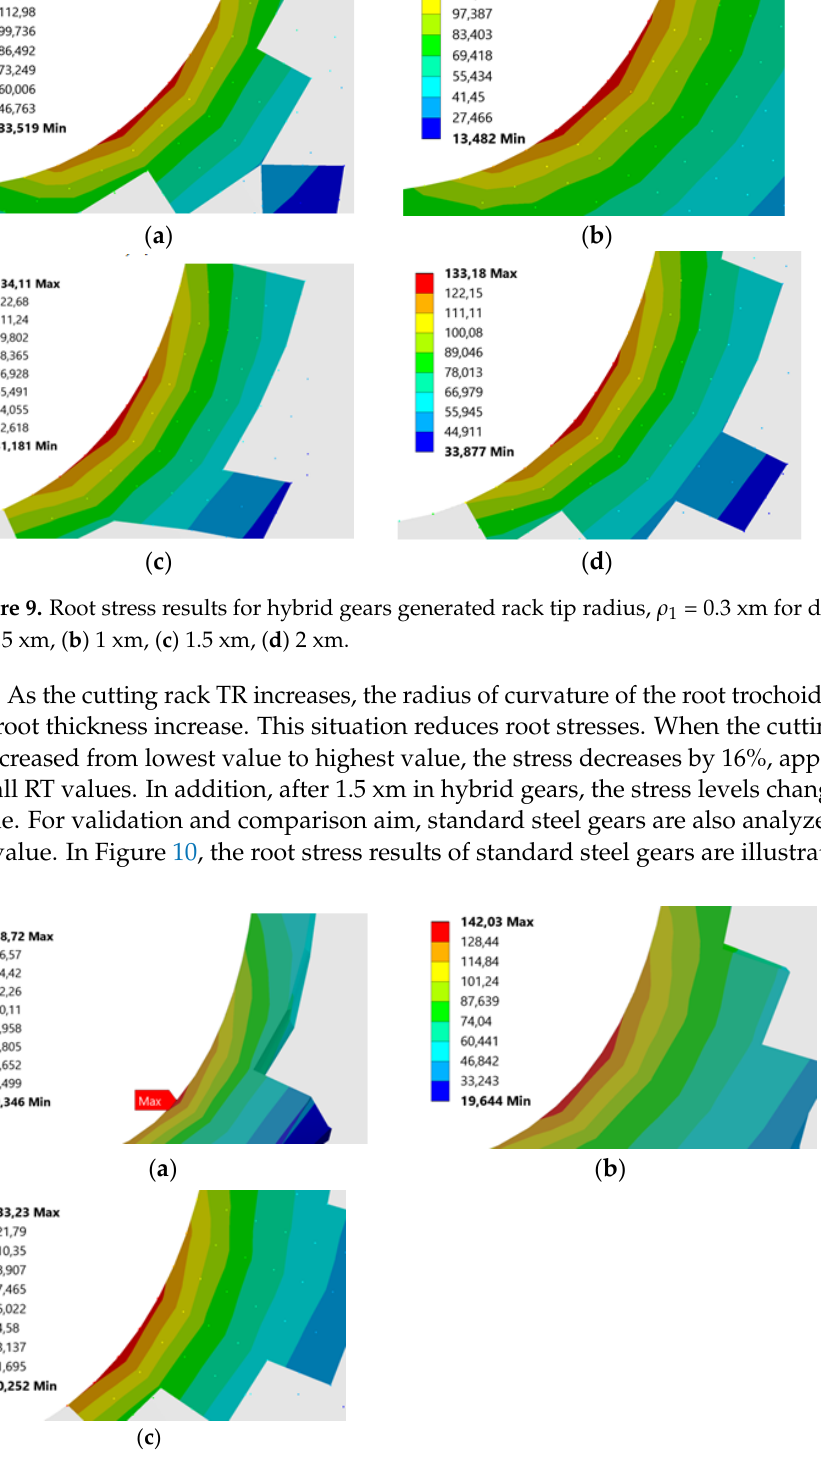
Figure 8. Root stress results for hybrid gears generated rack tip radius, ρ 1 = 0.2 xm for different RTs;